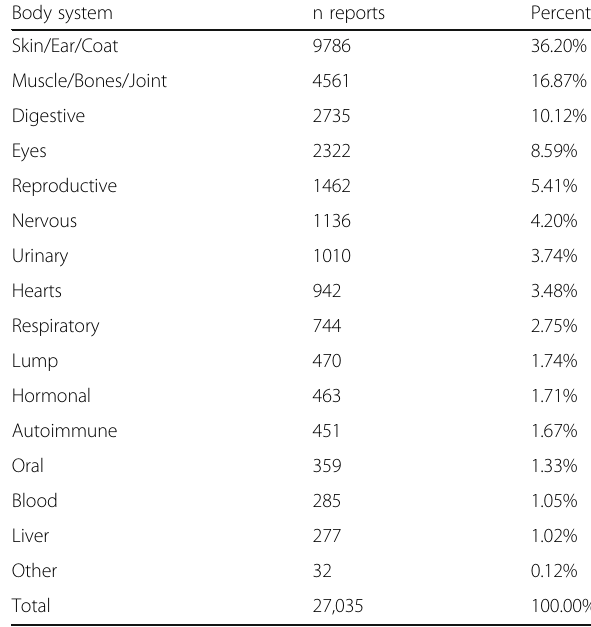
Table 2 Number and proportion of disorders reported by